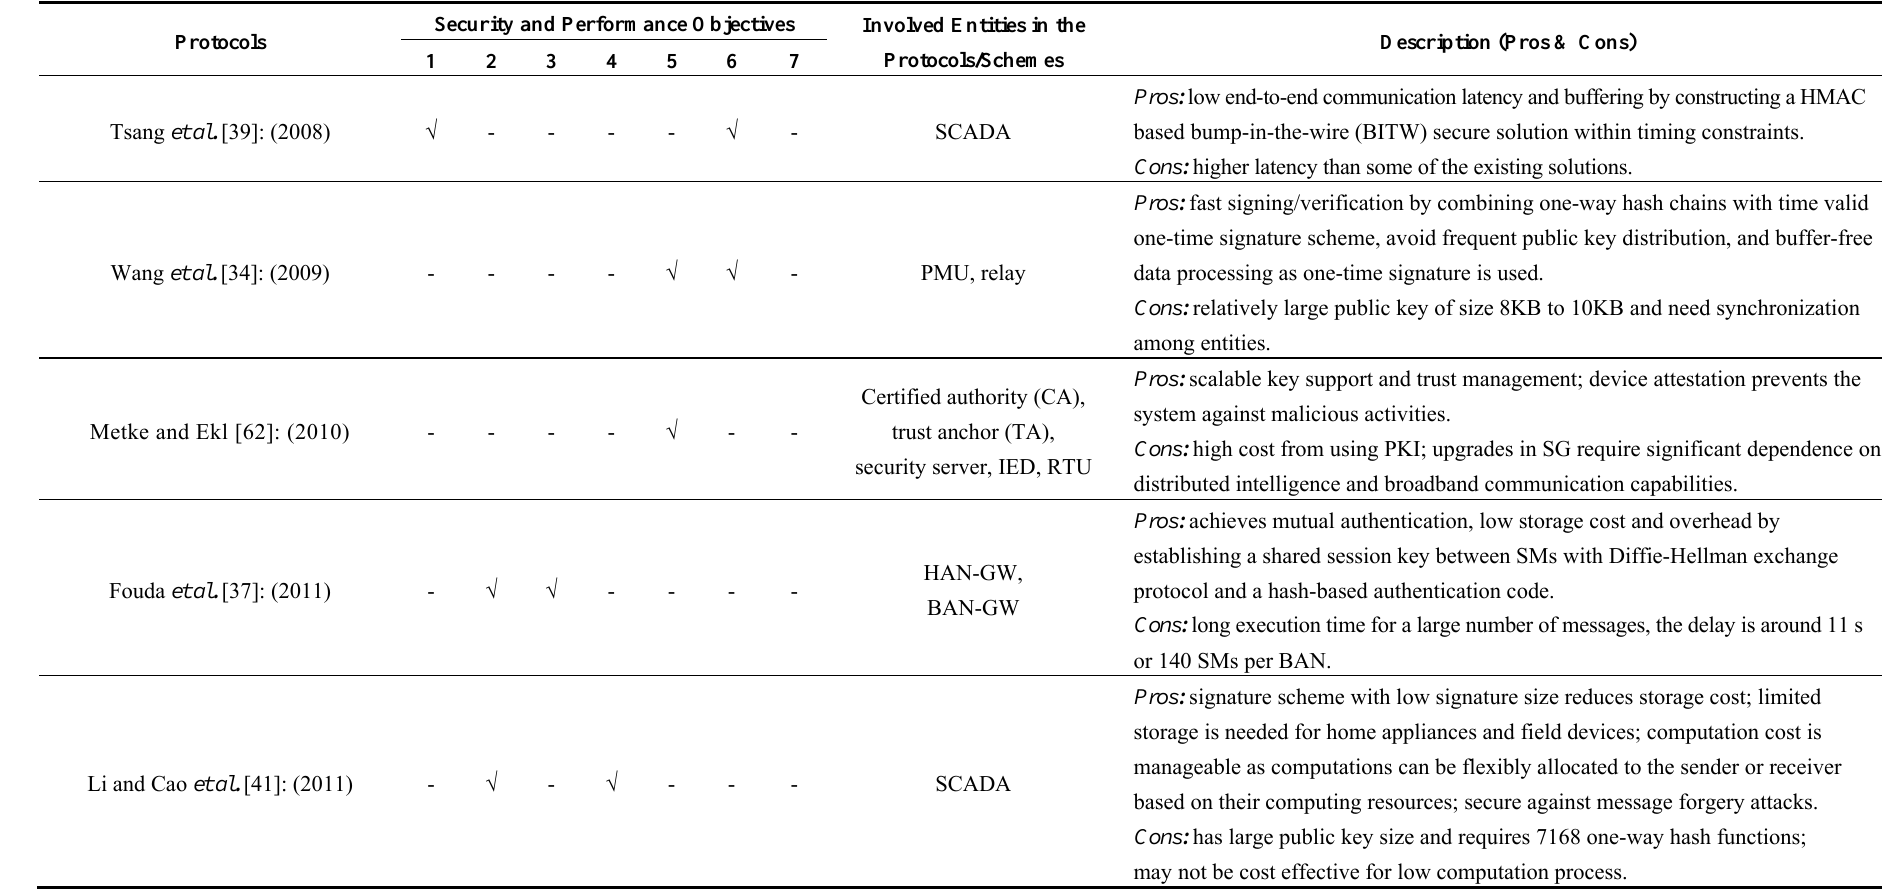
Table 3. Summary of existing authentication protocols/schemes. SCADA: supervisory control and data acquisition; HMAC: